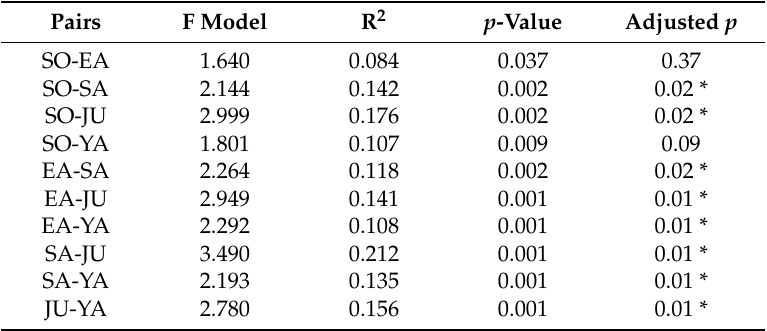
Table 5. MRPP test of the compositions of macroinvertebrate assemblages of the five rivers. MRPP Statistics SO EA SA JM YA delta 0.8978 0.9200 0.8557 0.8005 0.8989 Chance corrected within-group agreement A: 0.0721; Based on observed delta 0.8797 and expected delta 0.948.